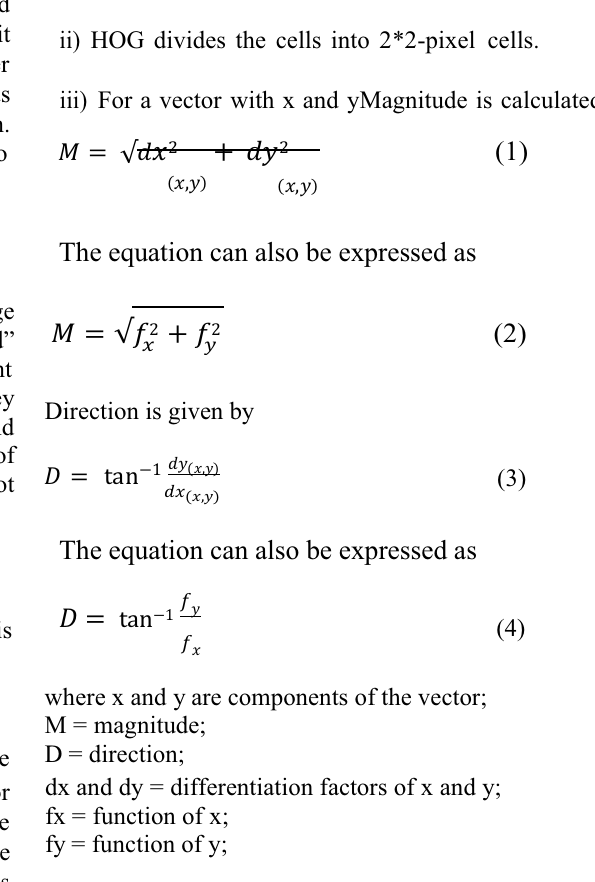
It is a rotation and scale invariant feature description algorithm. Histogram Oriented Gradients [HOG]